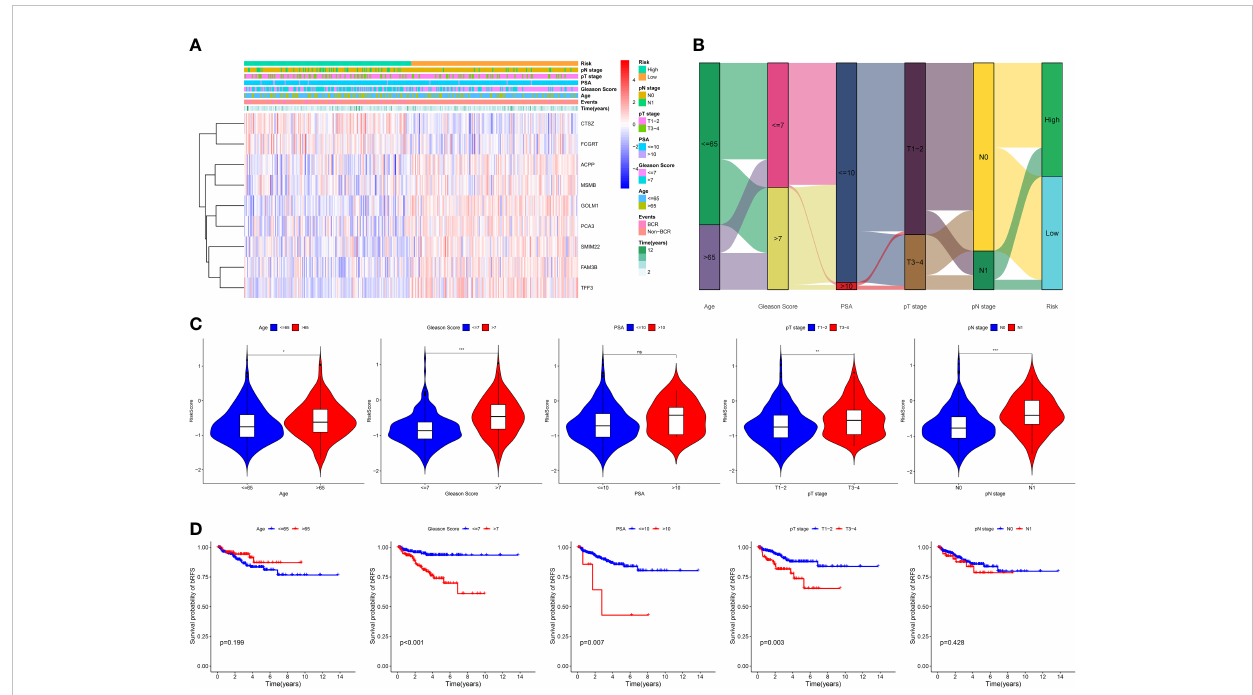
FIGURE 5 Correlation between MRMGPS and clinicopathological features in TCGA cohort. (A) The landscape of MRMGPS and clinicopathological features (pN stage, pT stage, PSA, Gleason Score, Age). (B) Sankey diagram displaying the distribution of samples in different subgroups strati fi ed by clinicopathological features. (C) Comparison of the risk score between different subgroups strati fi ed by clinicopathological features. (D) Kaplan – Meier curves for the probability of bRFS strati fi ed by clinicopathological features. PSA, prostate speci fi c antigen. * P < 0.05, ** P < 0.01, *** P <